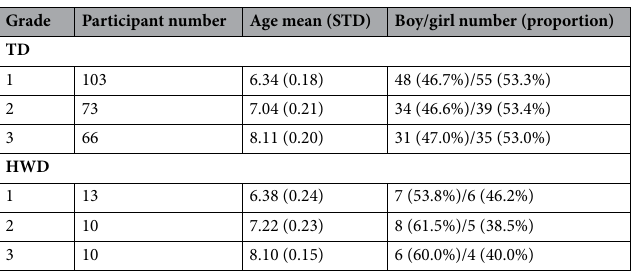
with typical development and handwriting difficulties. For constructing a reference for clinical implementation, the differences were also examined between genders and across the school years. Methods